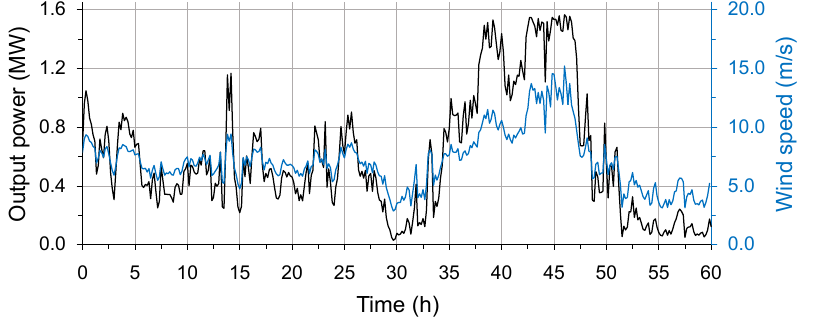
Figure 3. Measured output power (black line) and wind speed (blue line) time series of a wind turbine General Electric GE 1.5sl located in Zodel near the town of Görlitz. The depicted measurements are performed every 10 min over a period of 60 h.